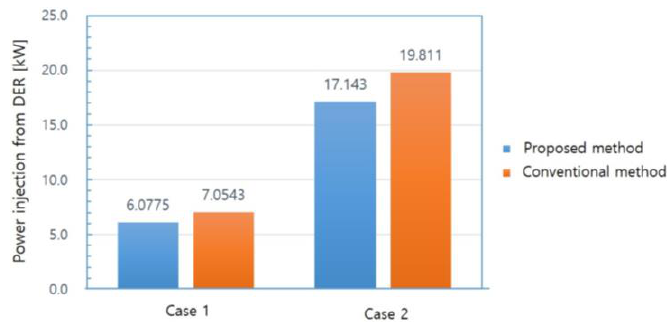
Figure 12. Voltage profile of the LVDC system under voltage control method (Case 2). (a) with AC/DC converter control; (b) with distributed energy resource control after AC/DC converter control.